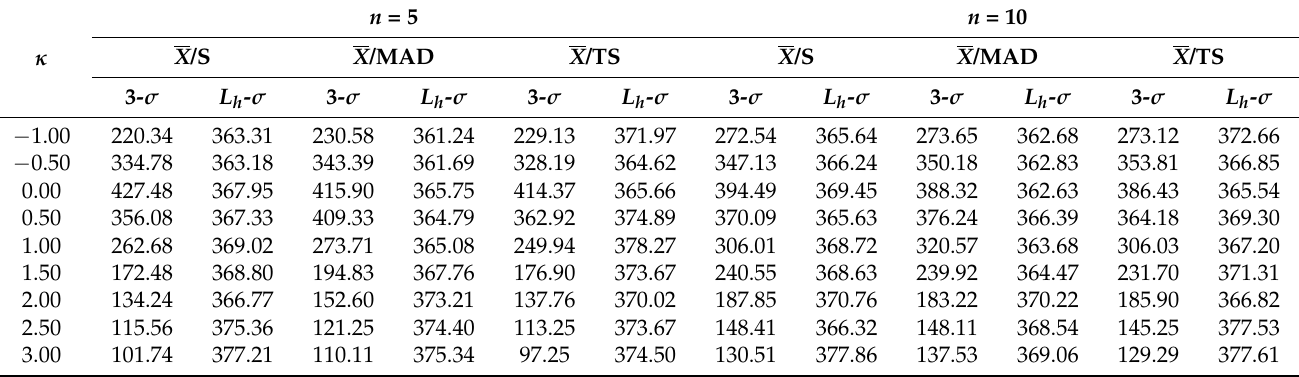
Table 5. ARL 0 for the WV mean control charts with different n and κ of a Weibull